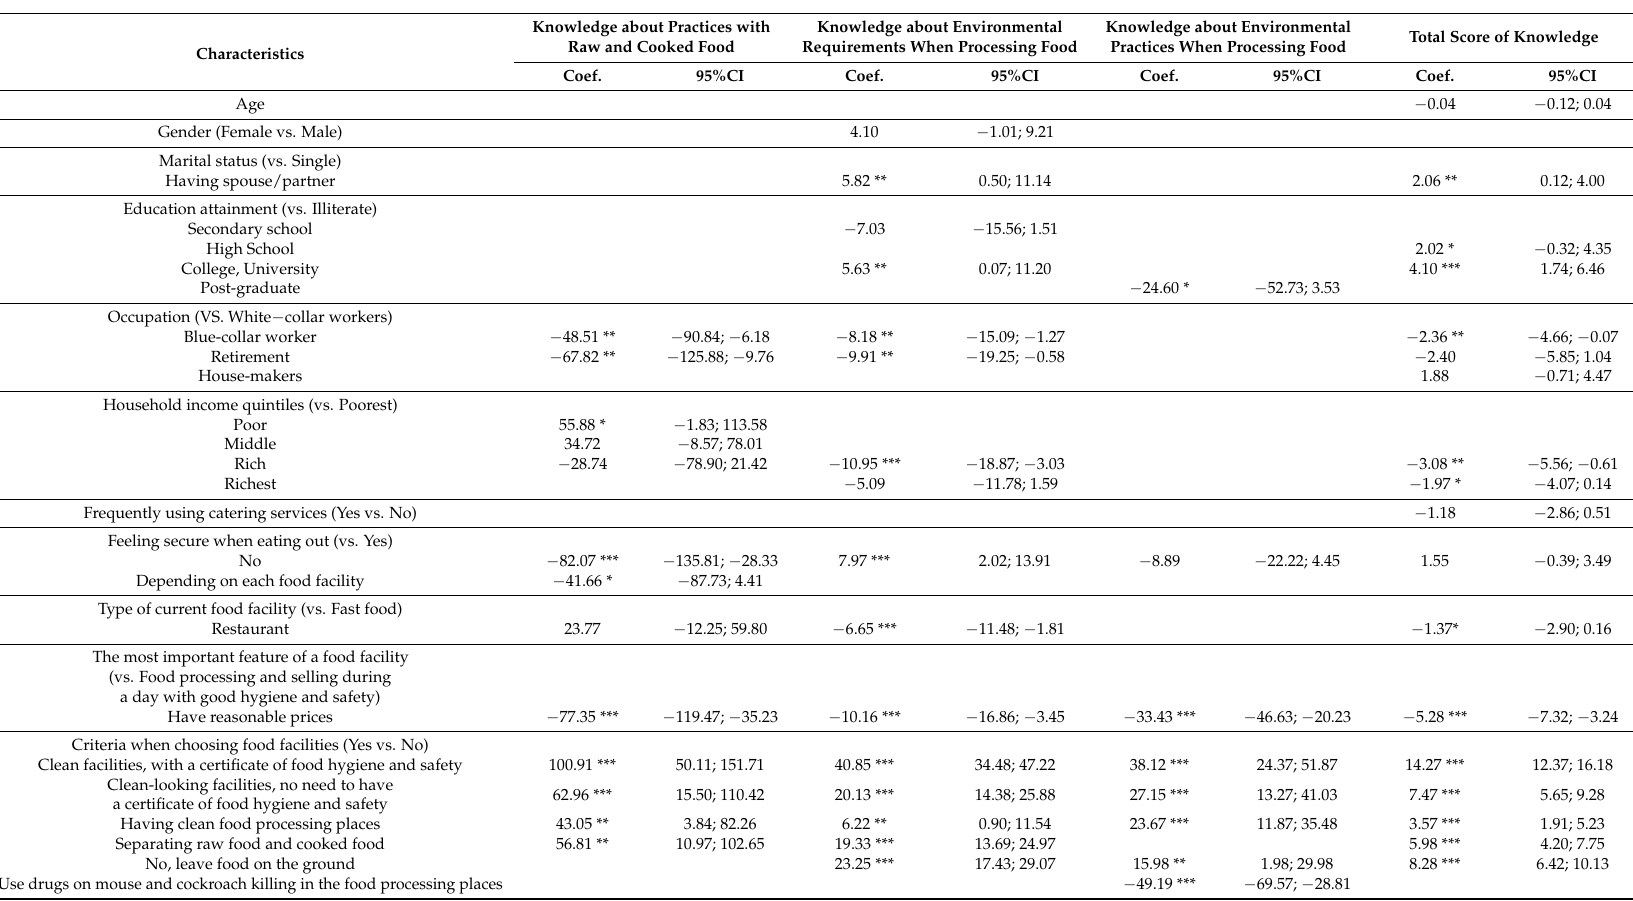
Table 4. Factors associated with knowledge of customers regarding hygienic practices of food handlers in food facilities.